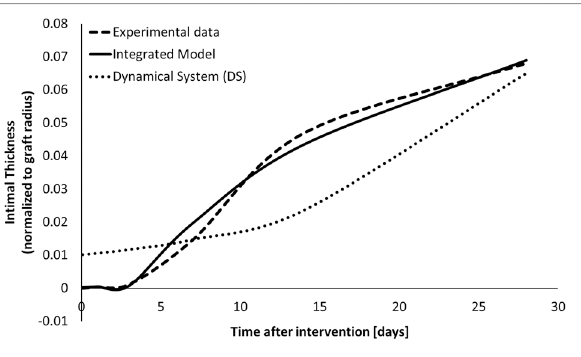
Fig 12. Calibration of the hybrid model. The temporaldynamic of intimal thickness is recorded as output of the DS (dotted line), from experimental data (dashedline), and as output of the integratedmodel (solid line).